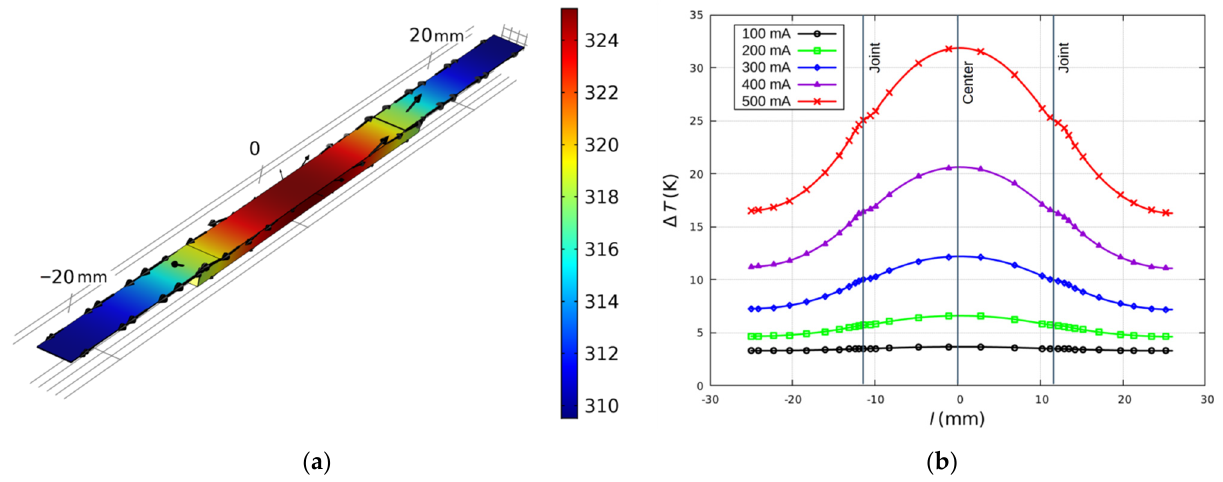
Figure 13. Numerical model results: ( a ) temperature (colors) and heat flux (arrows) distribution for 500 mA; ( b ) temperature profiles along the sample.